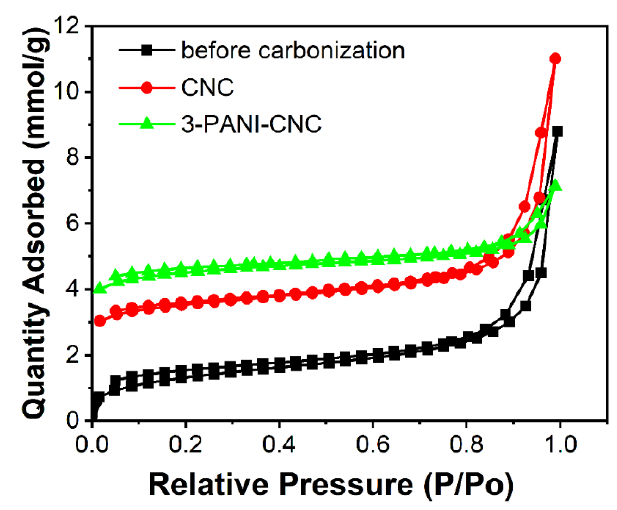
Figure 5. The BET surface of the different samples.